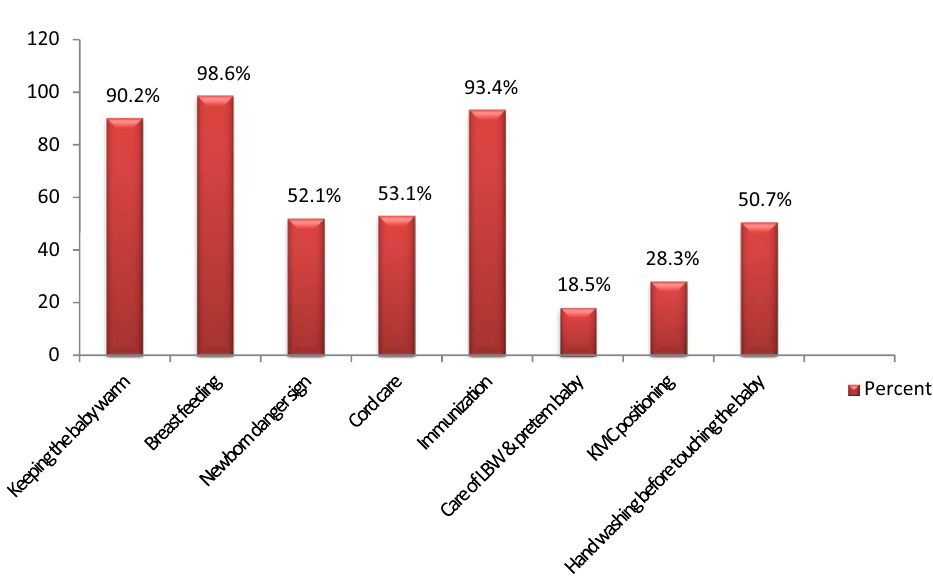
Figure 1. Types of received counseling messages about newborn care before or following last delivery among respondents from Health worker/HEW in North Shewa zone, Oromia Region, Ethiopia (N =